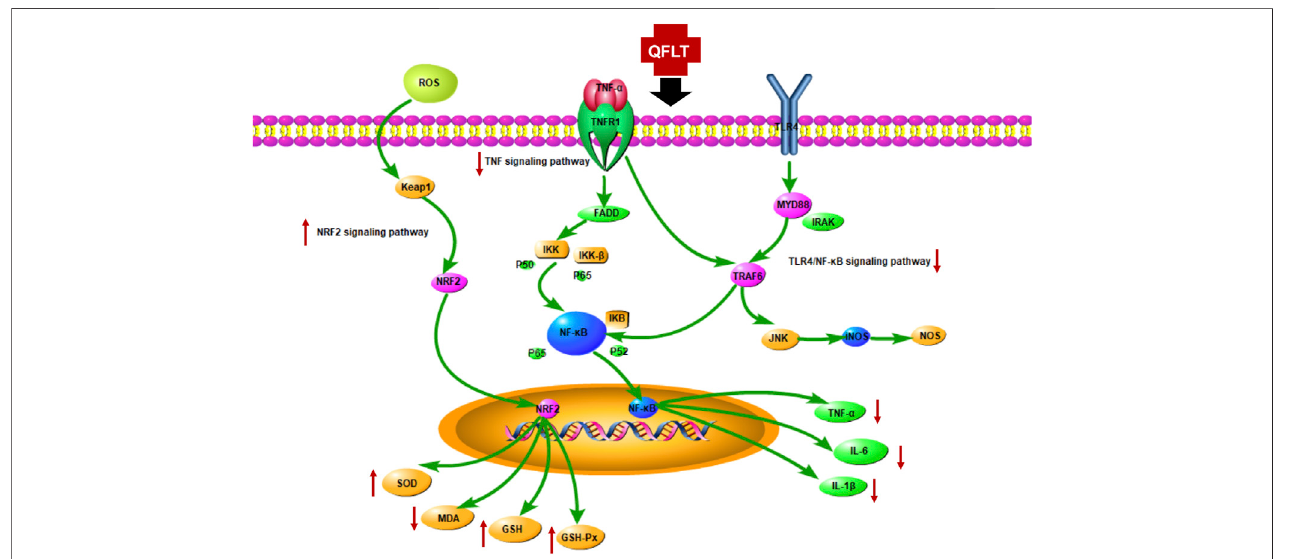
FIGURE 11 | The potential anti-in fl ammatory and anti-oxidative mechanism of QFLT against ALI/ARDS.